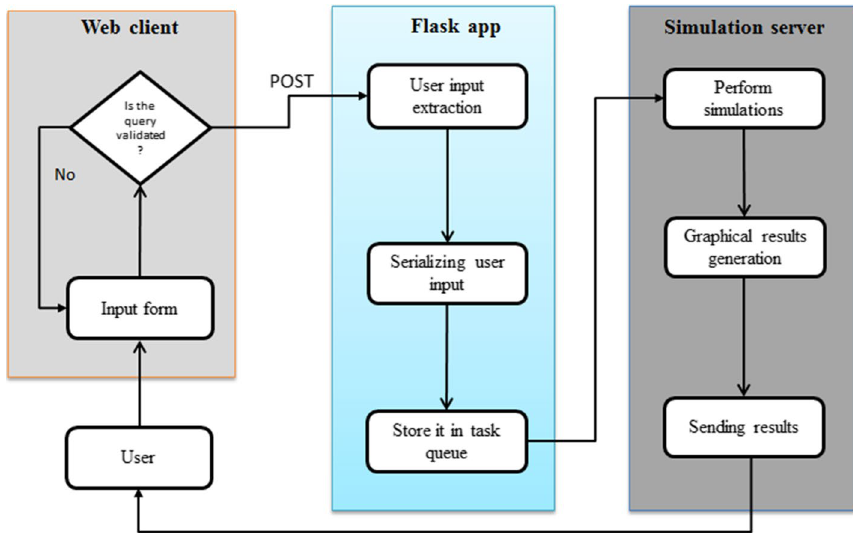
Fig. 1 System design of the